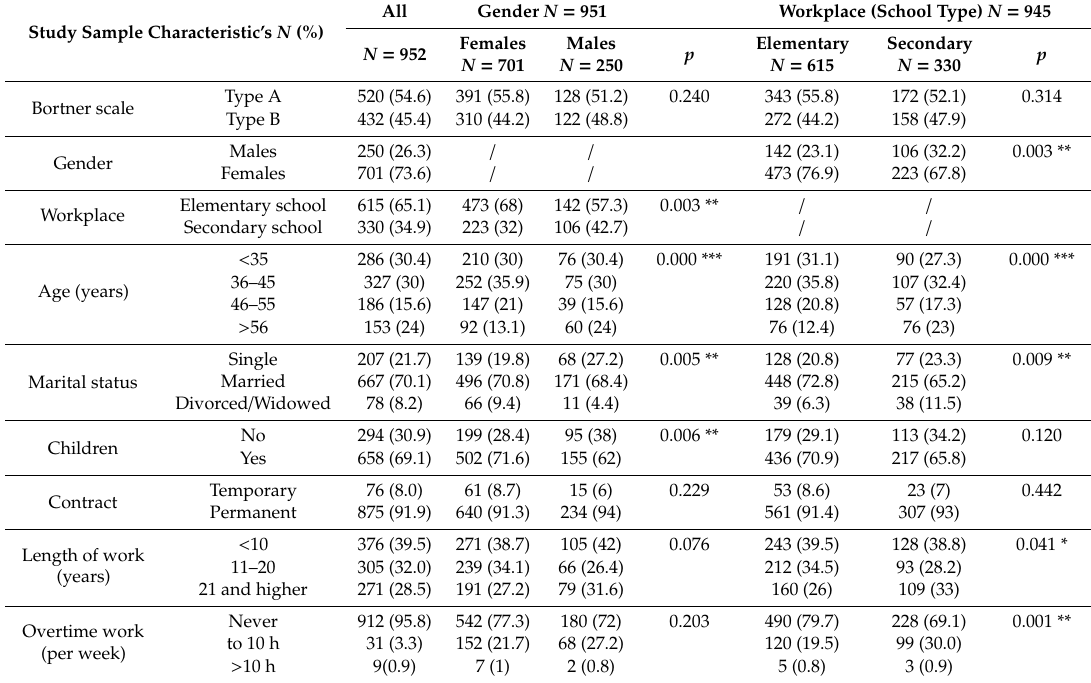
Table 1. Individual and socio-demographic characteristics of teachers stratified by gender and